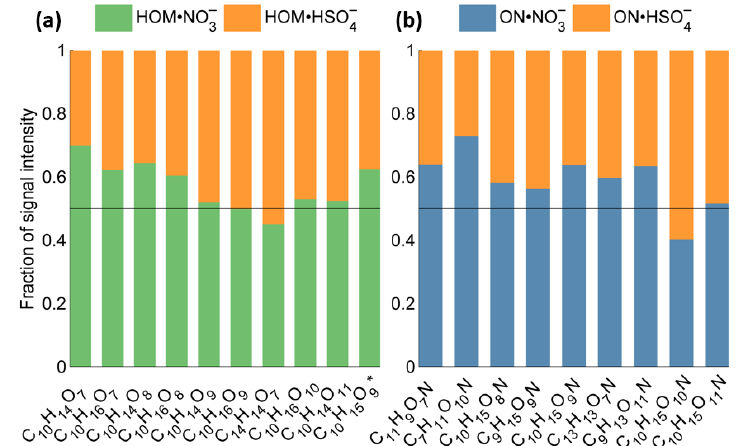
Figure 4. Naturally charged HOMs detected by the APi-TOF during daytime of 20 April 2013. In (a) we report the ambient ions that contain HOMs clustered ether with NO − (green) or HSO − (orange), while in (b) we show ambient ions that contain ONs clustered ether with NO − 3 4 (blue) or HSO − 4